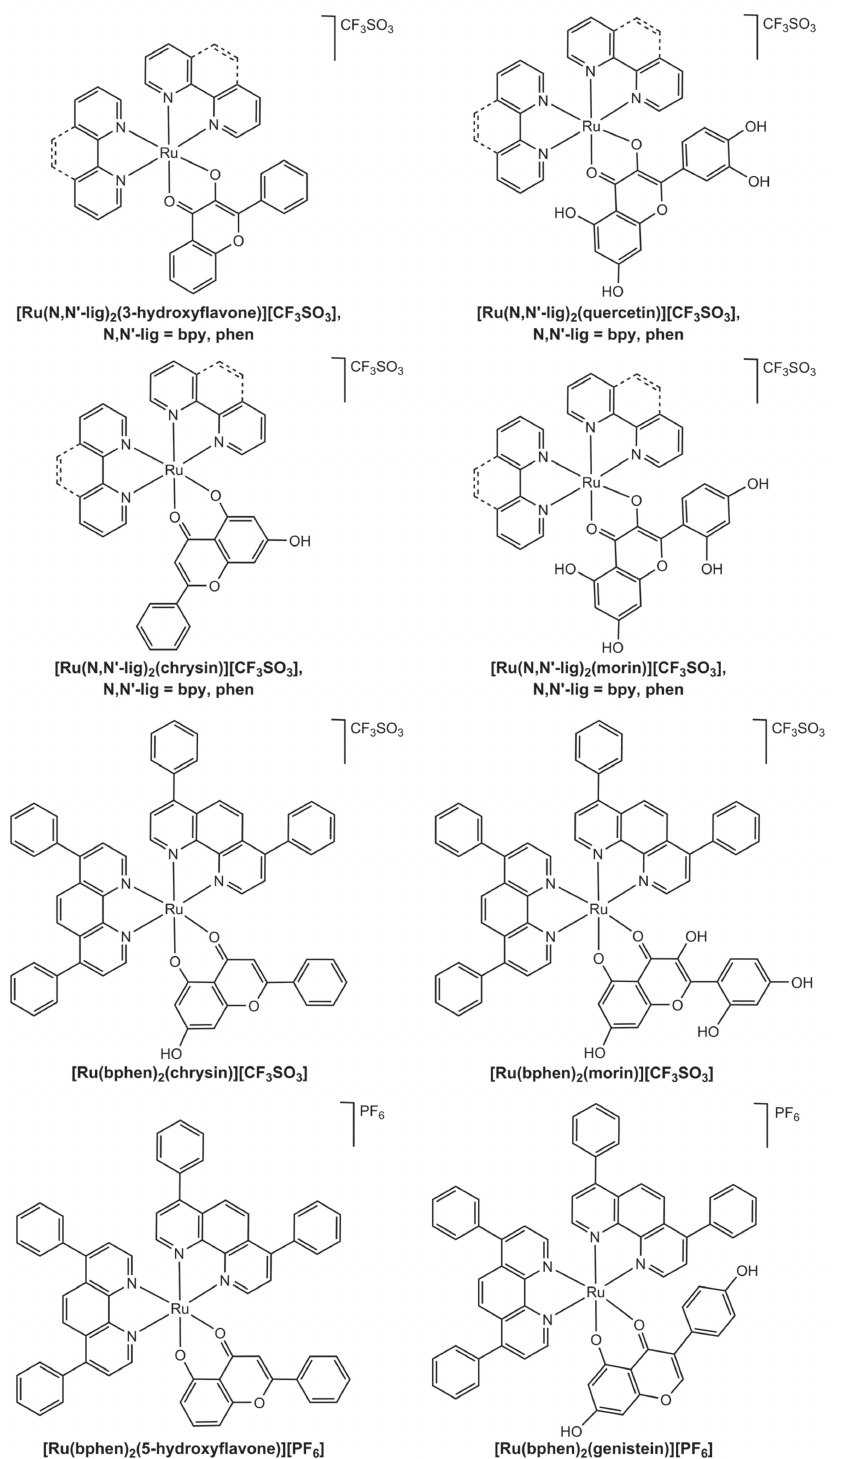
Figure 6. Structural representation of ruthenium polypyridyl complexes of the type [Ru(N,N’-lig) 2 (flv)] + . Two families of complexes are reported, one having N,N-lig = 2,2 (cid:48) bipyridine (bpy) or 1,10-phenanthroline (phen) and flv = 3-hydroxyflavone, quercetin, chrysin, or morin [31] and another family having N,N’-lig = bis -bathophenanthroline (bphen) and flv = 5- hydroxyflavone, genistein, chrysin, and morin [32]. Note that the unusual coordination at the 4,5- O , O site of the morin complex observed in the second family was achieved by means of a taylor-made synthesis that resorted to protective groups. Morin typically coordinates via the 3,4- O , O position, as observed in the corresponding complexes of the first